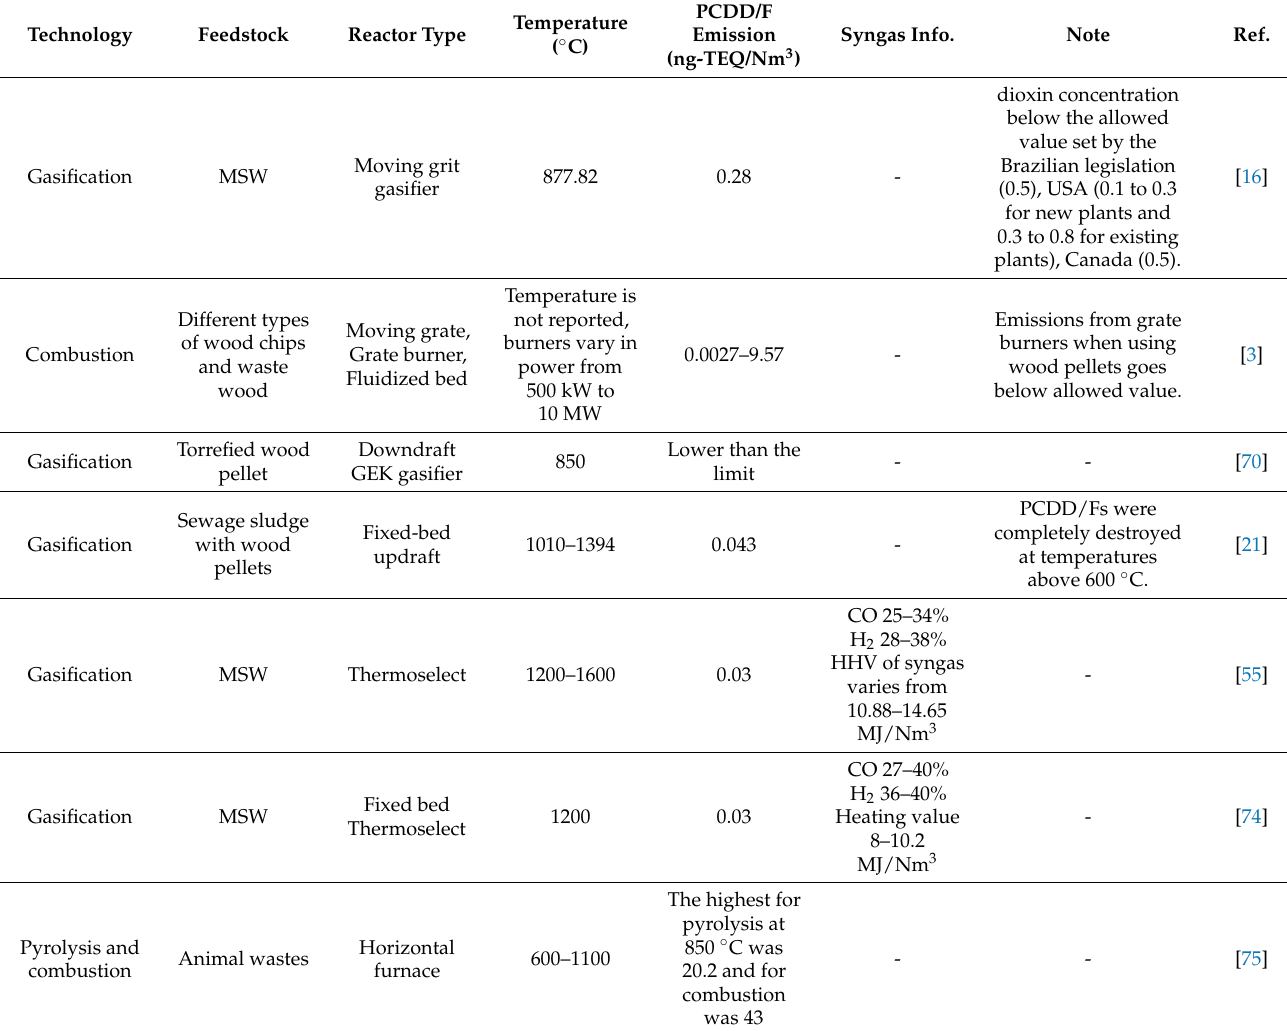
Table 1. Emission of dioxins from various combustion, pyrolysis, and gasification